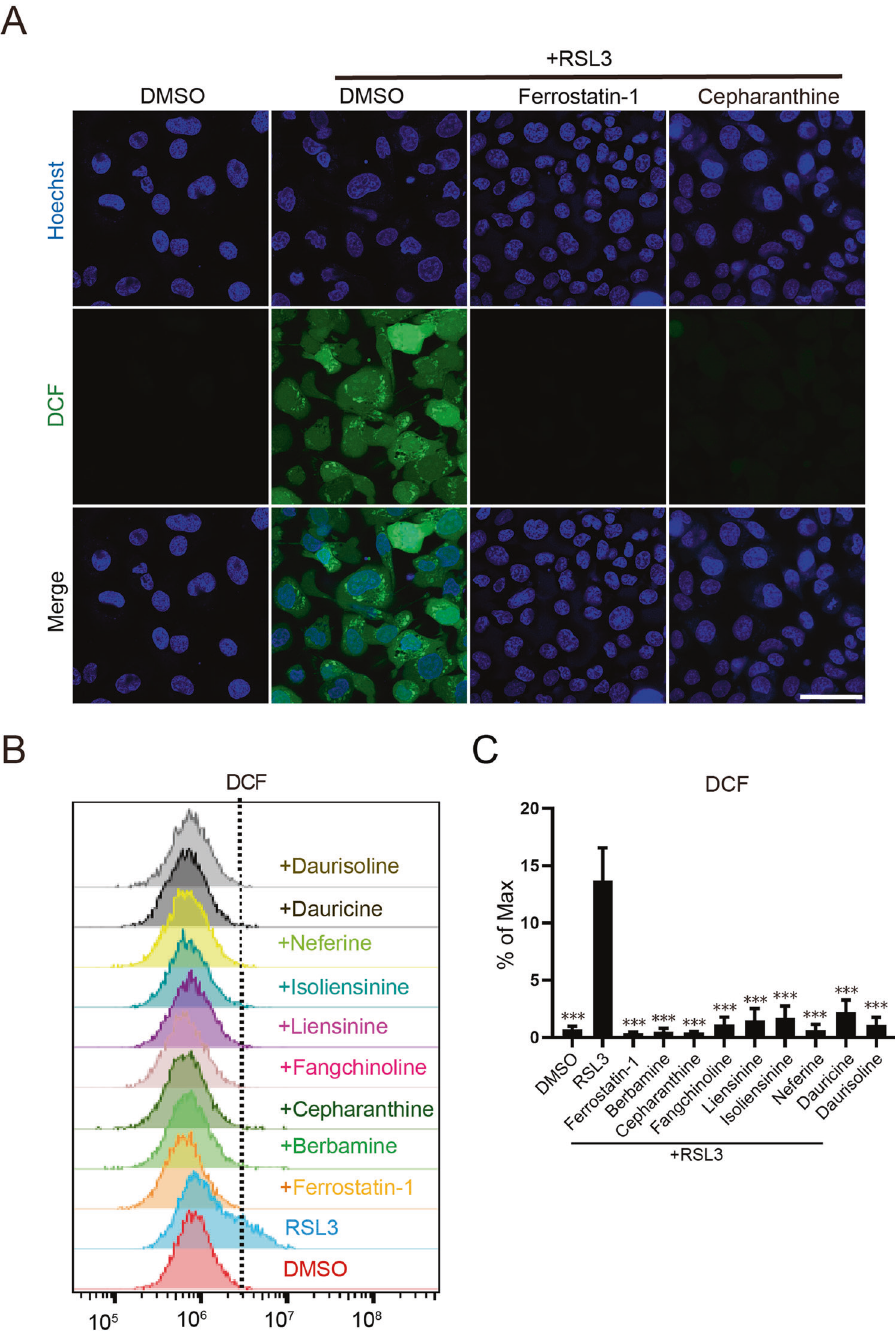
Fig. 2 Analysis of RSL3-induced cytosolic ROS by DCFH-DA (DCF) staining. A Representative images of cytosolic ROS immuno fl uorescence staining in HT1080 cells. Cells cultured on coverslips were treated with RSL3 (2 μ M) plus a testing compound (5 μ M) or ferrostatin-1 (5 μ M) for 4 h, labeled with the DCFH-DA probe (10 μ M for 30 min) then cytosolic ROS levels were analyzed by confocal imaging. Scale bar: 50 μ m. B Cytosolic ROS assessed by fl ow cytometry. Cells were treated as in ( A ) then analyzed using the BD Accuri C6 Plus Flow Cytometer. C Statistical results for ( B ). Data represent mean ± s.d. from three biological repeats and p value (vs. RSL3 alone) is determined by ordinary one- way ANOVA with Dunnett ’ s multiple comparisons test. ***, p <